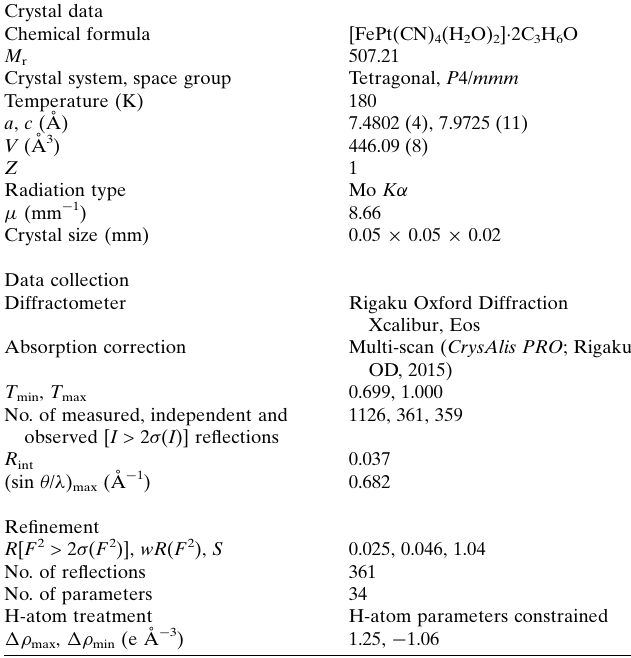
Table 1 Hydrogen-bond geometry (A˚ , (cid:4) ).